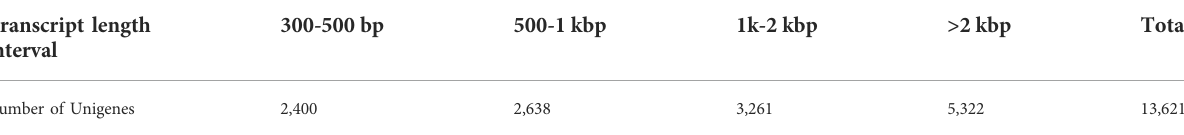
TABLE 4 Length distribution of F. solani species complex bio fi lm unigenes.